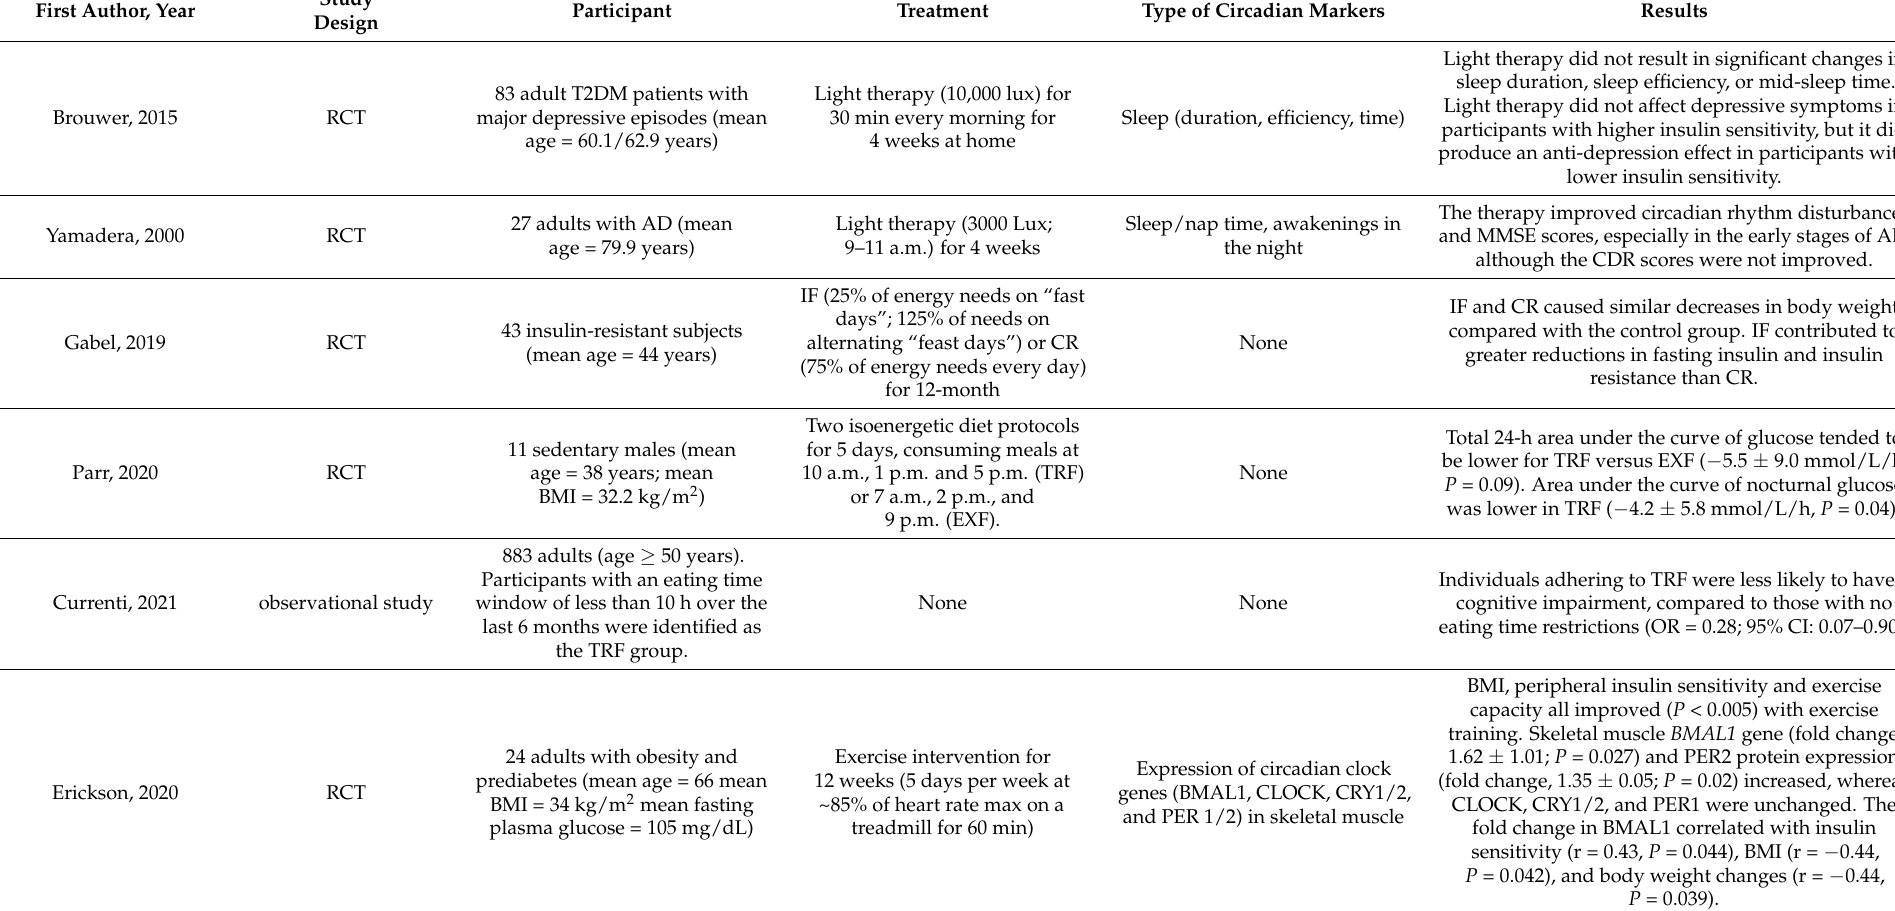
Table 3. Therapeutic strategies targeting circadian rhythms for T2DM and AD in human